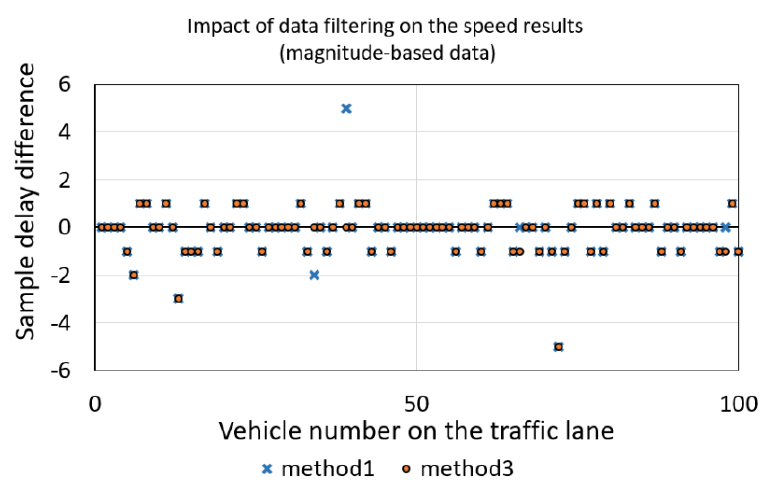
Figure 8. Sample delay difference obtained as a result of data filtering using a ten-sample moving average, N = 3000.